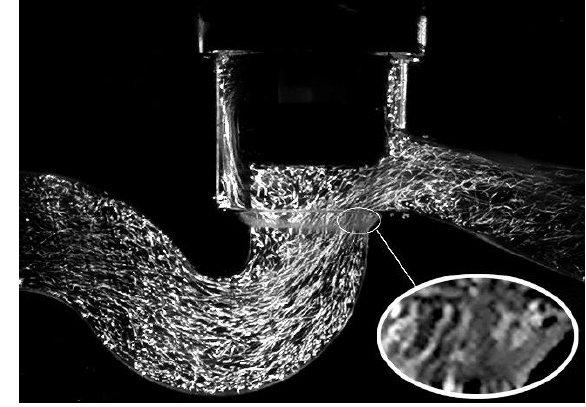
Fig. 6. Visualization in the axial plane of the model. Working fluid was the water (Ri